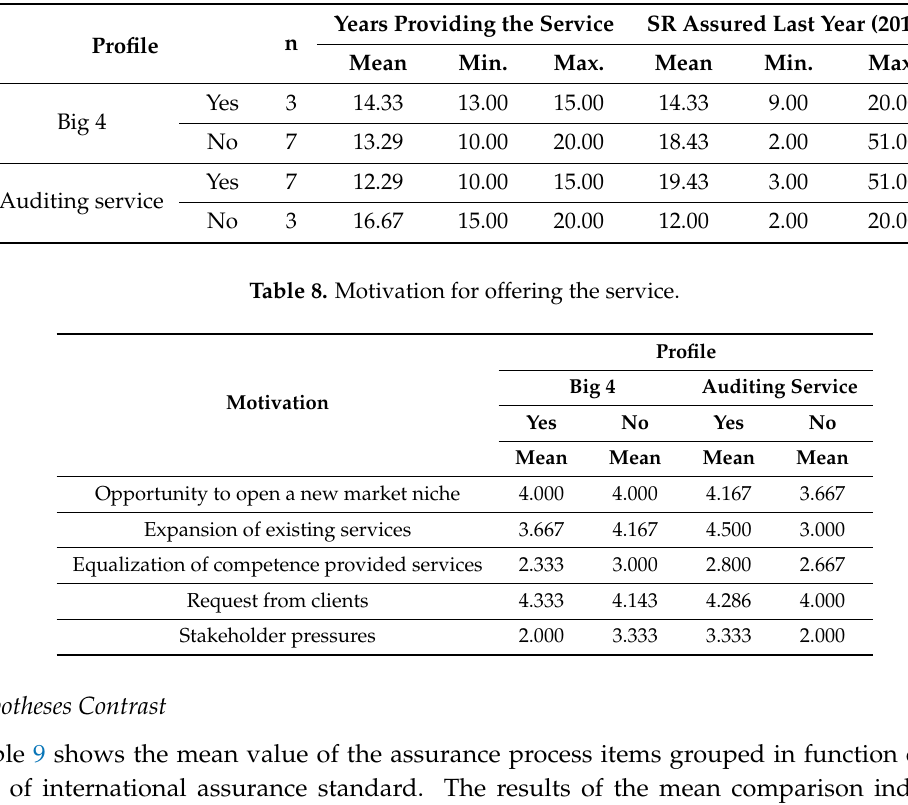
Table 7. Providers responding the questionnaire (N = 10).